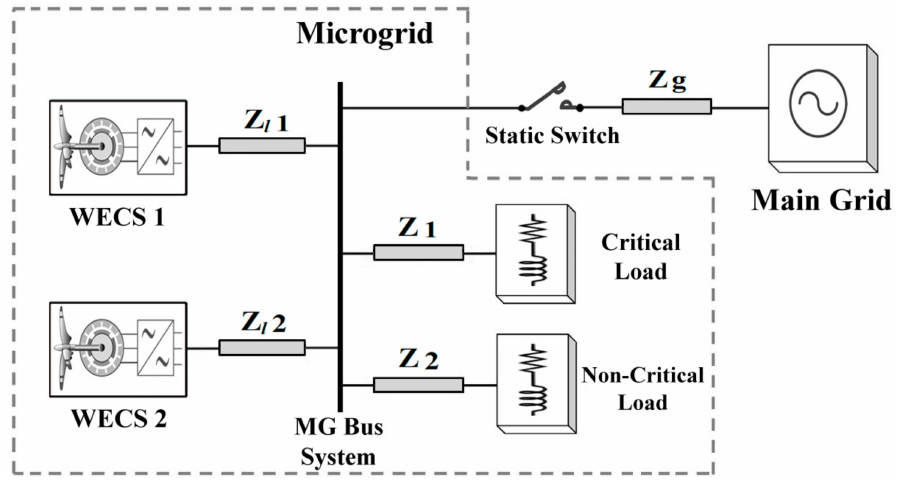
Figure 1. Typical structure for the wind energy conversion system (WECS) microgrid